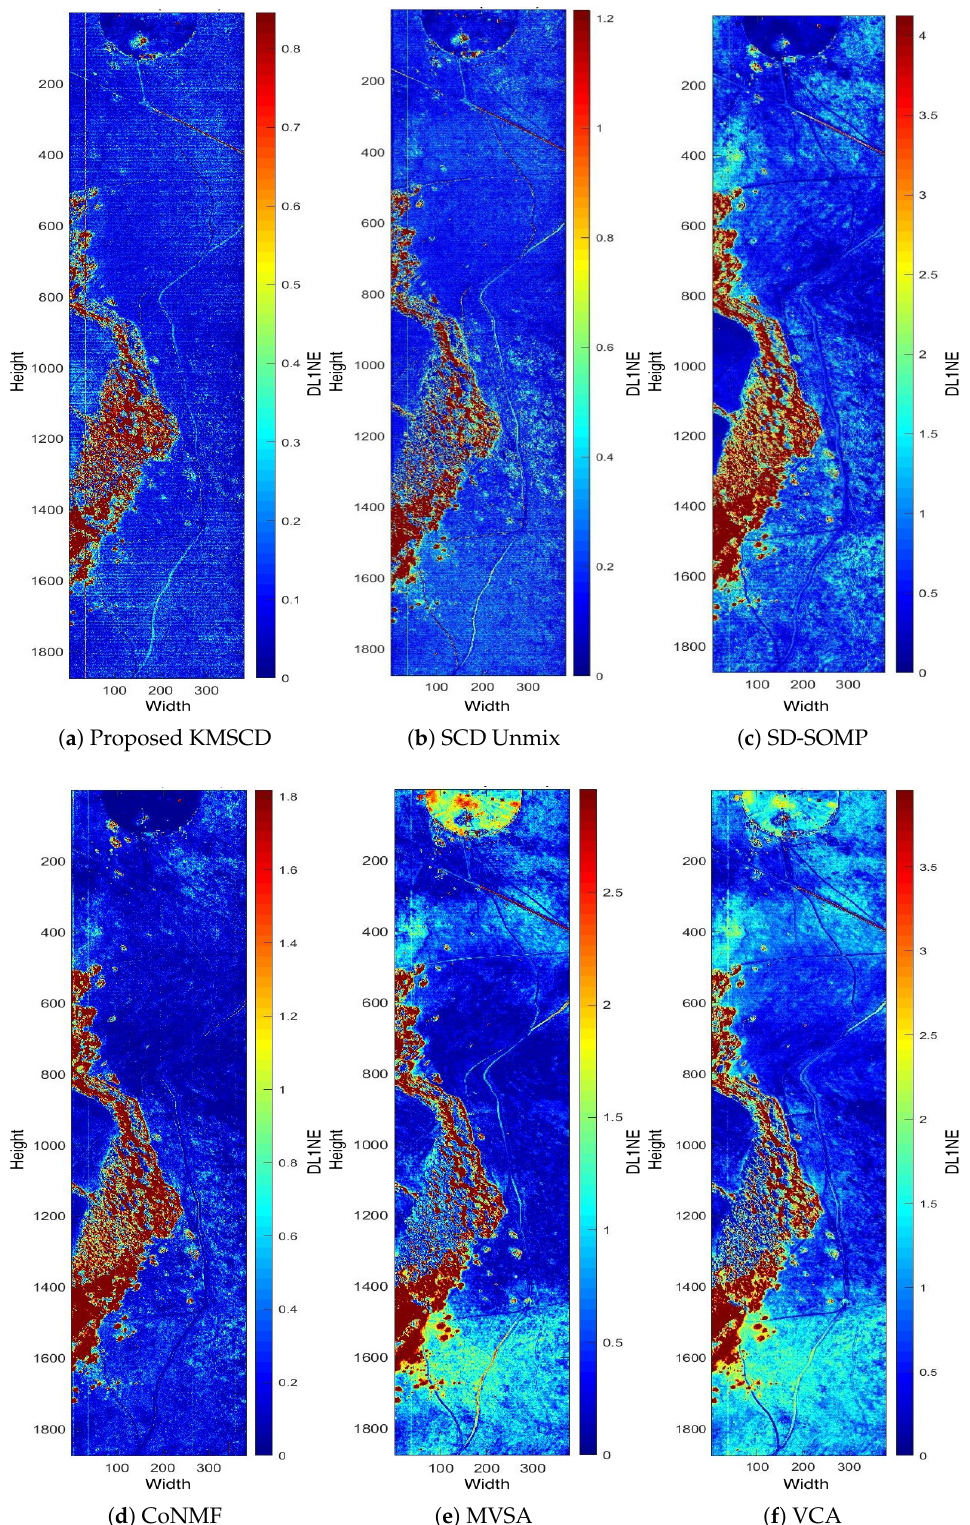
Figure 6. False-colour map of DL1NE of different methods on H23 Dual scene when trained from the first 1000 lines, whose mean error is mentioned in Table 2. Each of the error maps has been presented in various scales of [0 to 3 × mean(DL1NE)], such that the consistency of the reconstruction performance over the entire scene among all methods can be